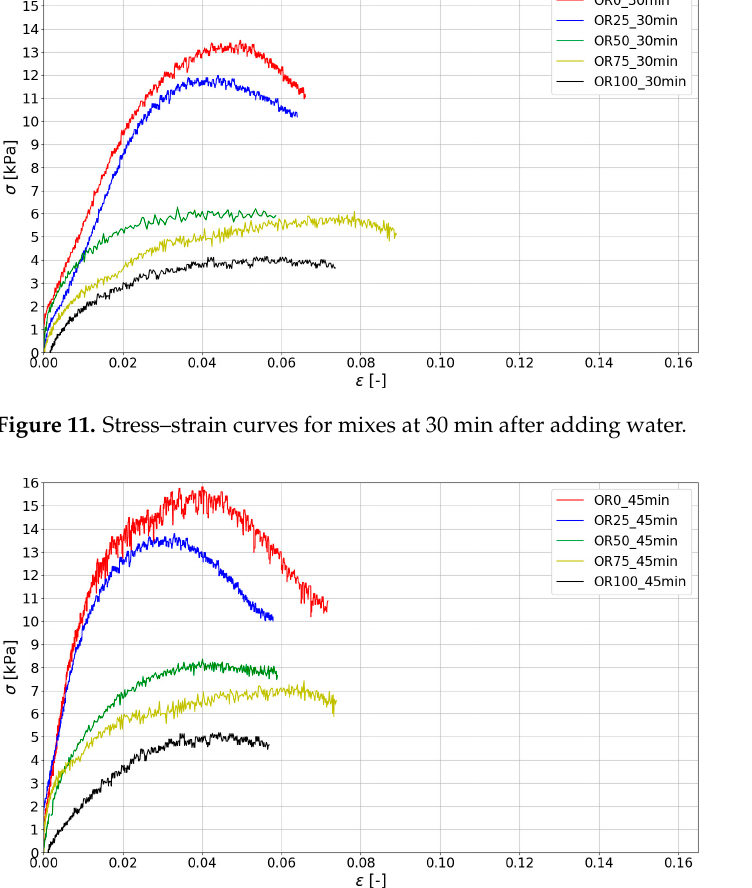
Figure 12. Stress–strain curves for mixes at 45 min after adding water.